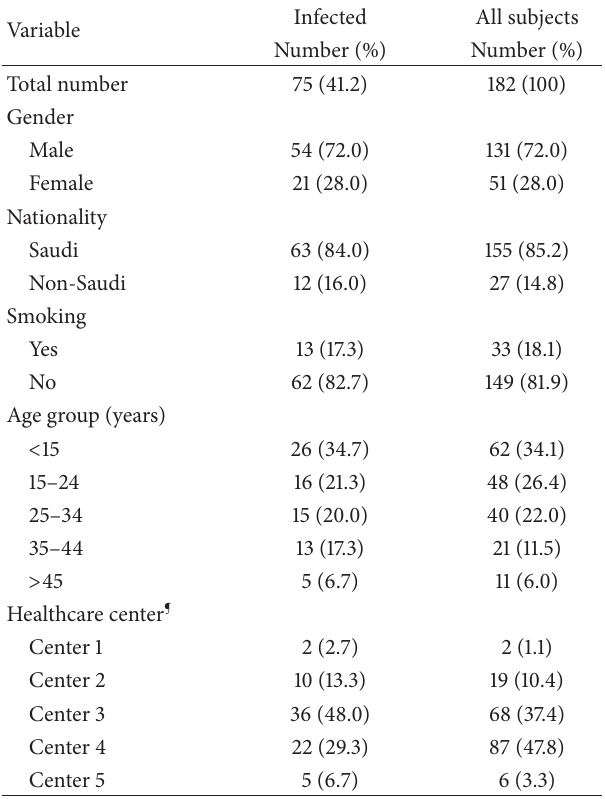
Table 1: Summary of demography characteristics of patients with upper respiratory tract infection in the community in Jazan province, Saudi